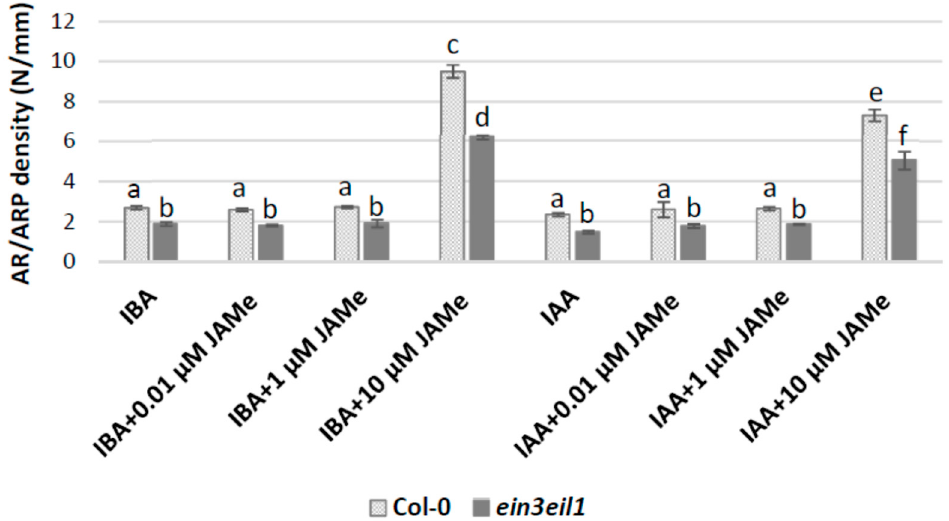
Figure 6. Mean density of adventitious roots (ARs) and adventitious root primordia (ARPs), evaluated as N / mm ( ± standard error (SE)) in the basal 5 mm of the hypocotyl of Col-0 (wt) and ein3eil1 double-mutant seedlings cultured with IBA (10 µ M) or IAA (10 µ M), alone or combined with 0.01, 1 or 10 µ M JAMe. Di ff erent letters among di ff erent treatments within the same genotype, or between the two genotypes within the same treatment, indicate significant di ff erences at least at p < 0.05. The same letters indicate no significant di ff erence. Two-way ANOVA followed by Tukey’s post-test. n = 30.